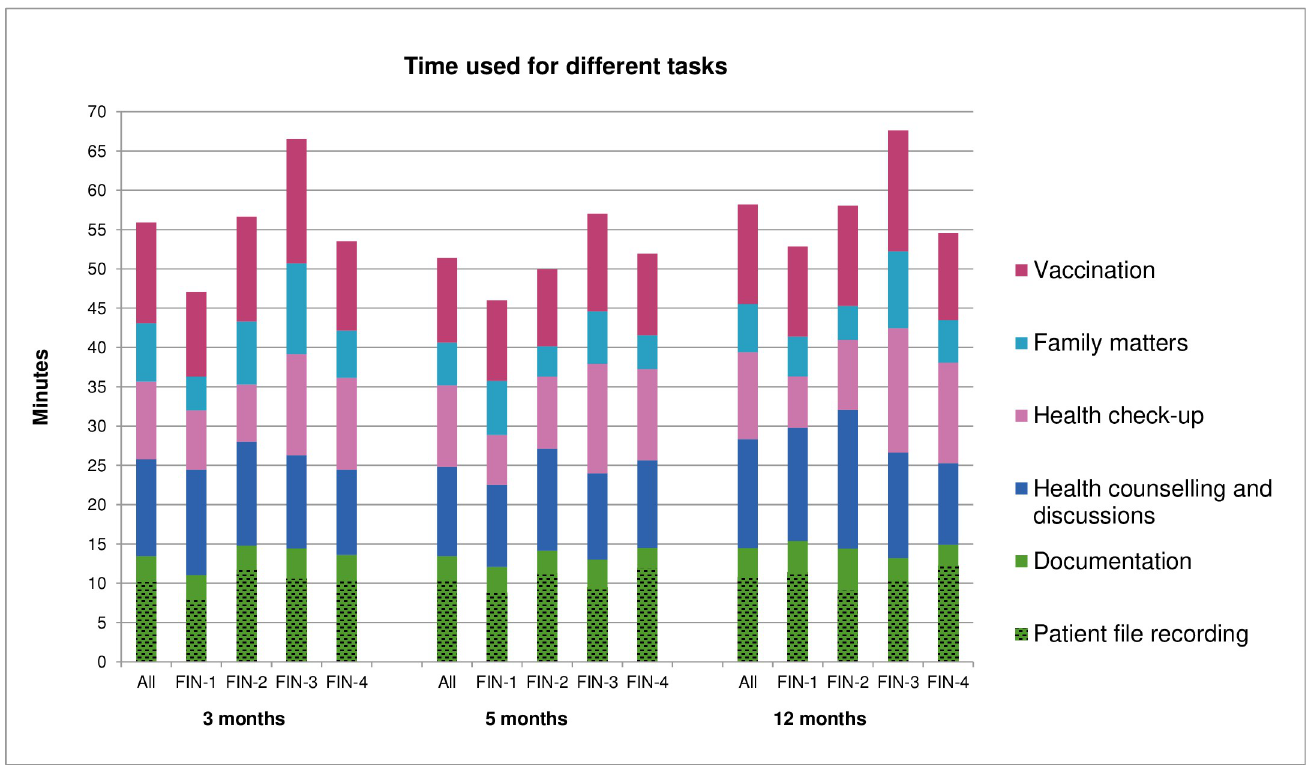
Fig 2. The observed time used for different task during 3, 5 and 12 month visits. The tasks belonging to each task group are shown in Table 1. Note: recording patient file is included in the documentation task group.